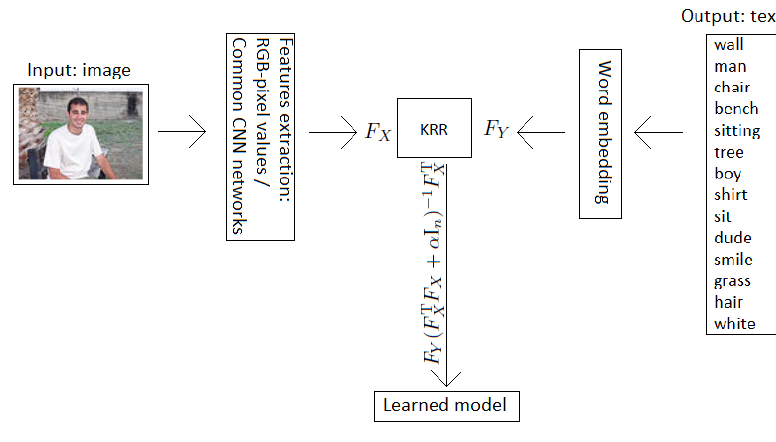
Figure 2. Framework of the proposed